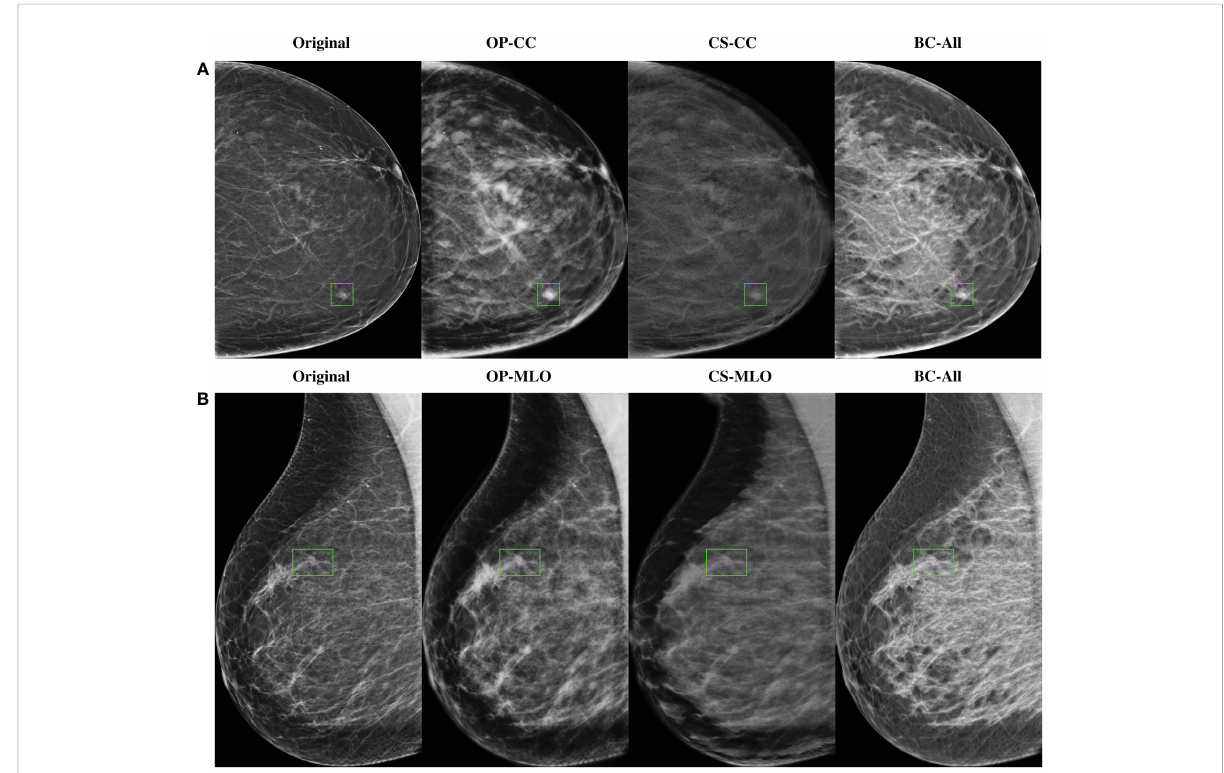
FIGURE 5 Samples of high-density synthetic mammograms generated with the different CycleGAN models. On the left, the input BI-RADS A mammogram from OPTIMAM Hologic dataset. (A) CC view, (B) MLO